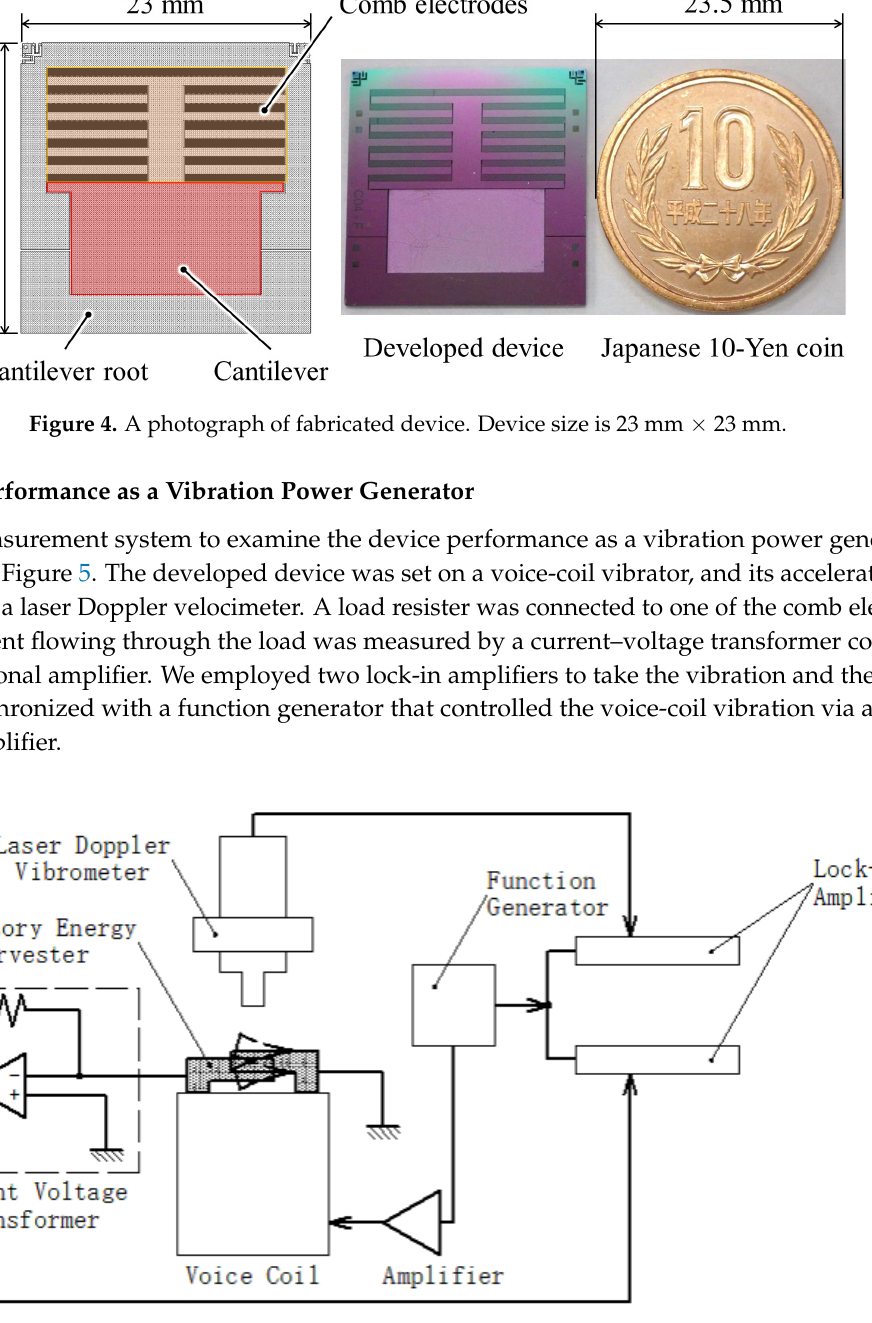
Figure 5. A schematic of the measurement setup to evaluate the fabricated vibration power